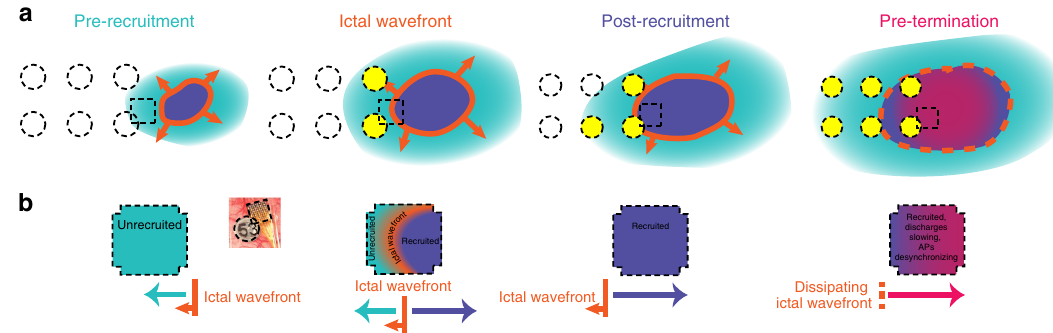
Figure 8 | Summary model of spatial dynamics of seizure evolution and termination. ( a ) Schematic showing snapshots of seizure progression through the four seizure epochs. Colours represent the spatial organization of the epochs shown in time series data of Fig. 1. Dashed-line squares represent the MEA footprint, and dashed-line circles represent ECoG electrodes. Yellow ECoG electrodes represent those exhibiting hypersynchronous ictal activity in the low-frequency (0.3–50Hz) LFP. As the recruited region (seizure core) gradually expands to envelope the MEA site, the ictal wavefront approaches the site, passes through it and then continues to move away from the site. ( b ) Schematic depictions of travelling wave activity across the MEA microelectrodes during each of the four seizure epochs. Rapidly moving travelling waves across the MEA change direction based on the MEAs location relative to the slowly moving ictal wavefront.